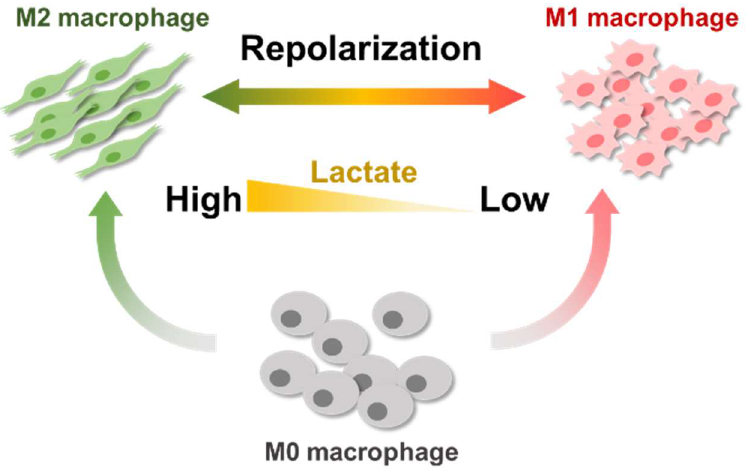
Figure 8. In vitro lactate directly modulates the distribution of M1/M2 macrophage from M0 mac-